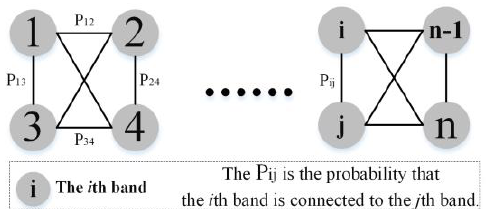
Figure 2. The Markov graph for the relationship between bands of